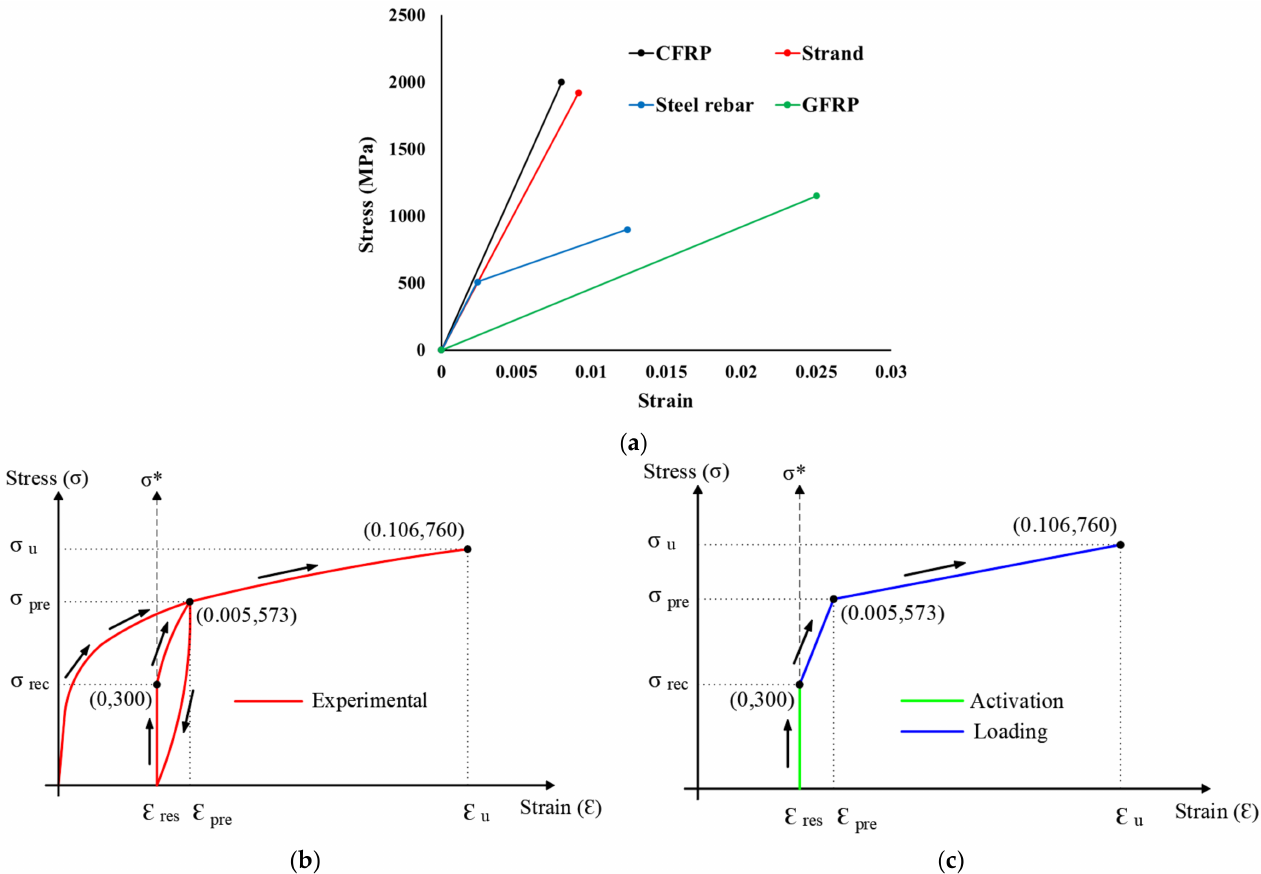
Figure 7. Stress–strain relationship of ( a ) CFRP, steel rebar, strand, and GFRP in ABAQUS, ( b ) Fe-SMA from experiment [31], and ( c ) Fe-SMA curve defined in